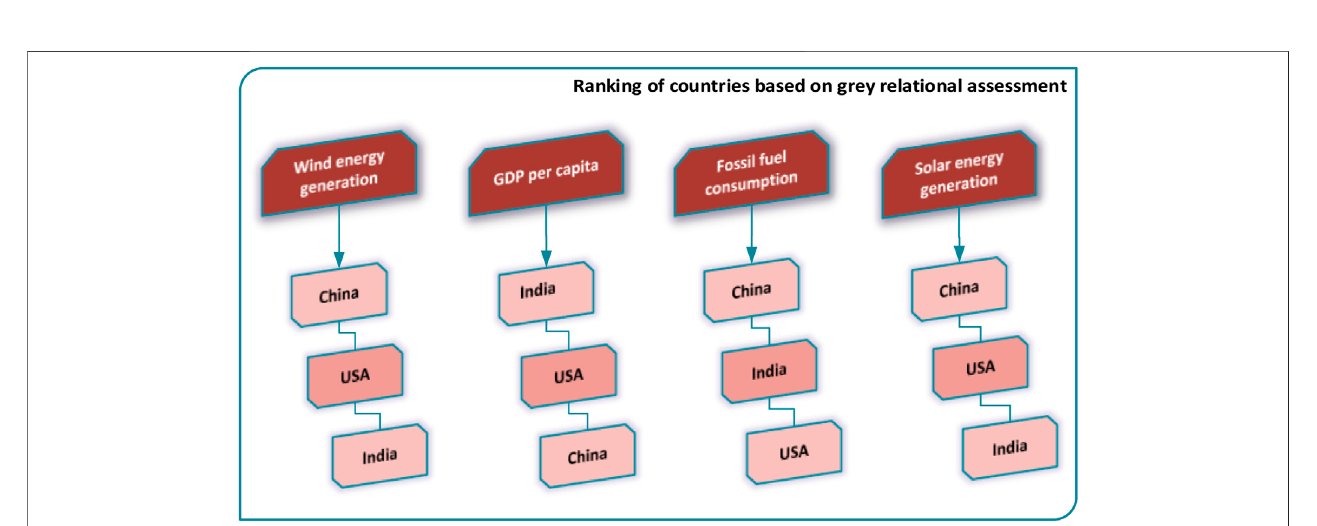
FIGURE 8 | Ranking sequences of selected nations based on GRA